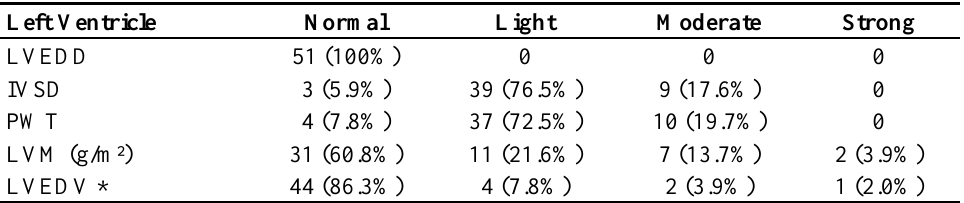
Table 2. Myocardial hypertrophy in male triathletes.